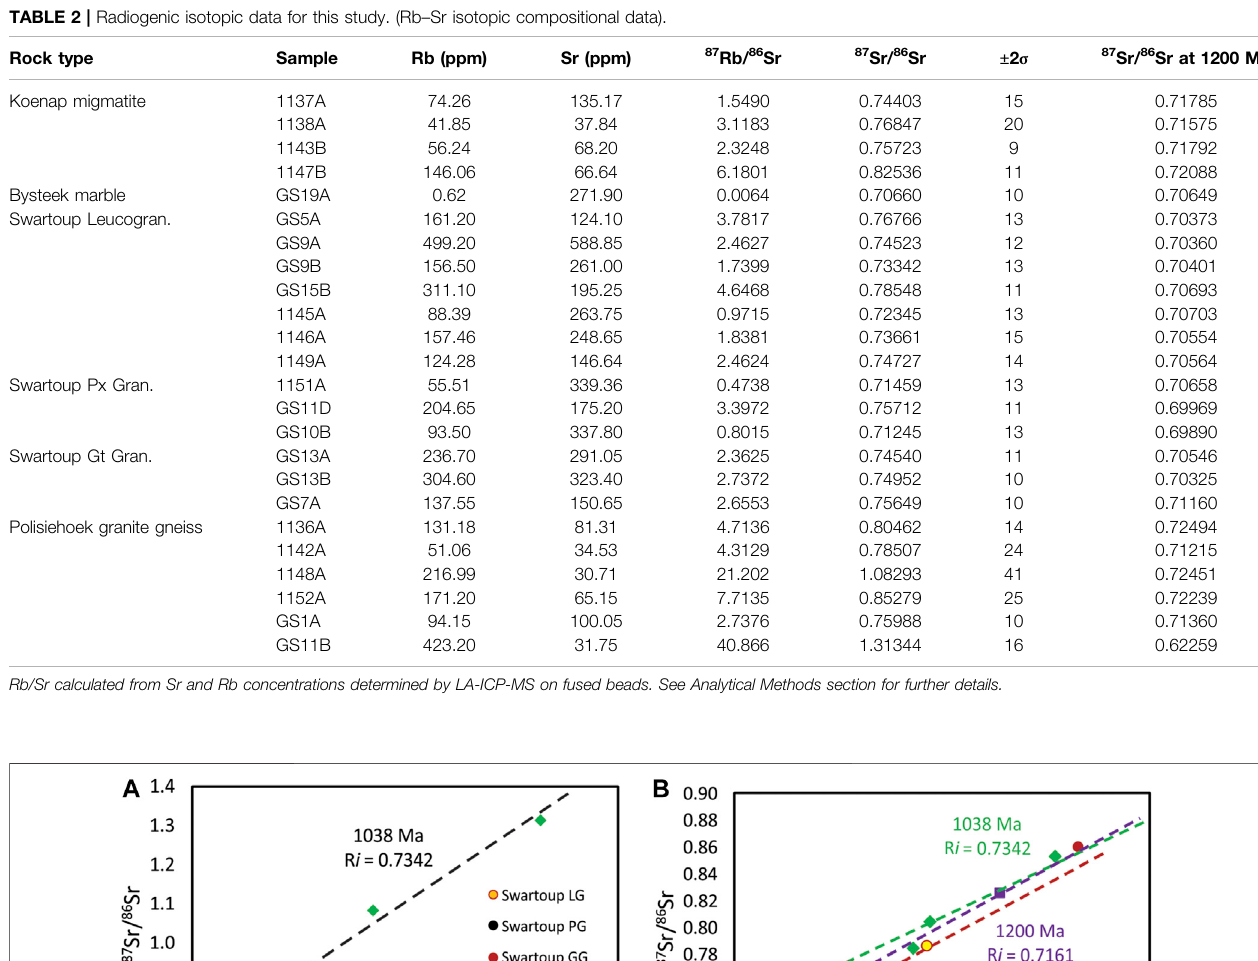
Frontiers in Earth Science |